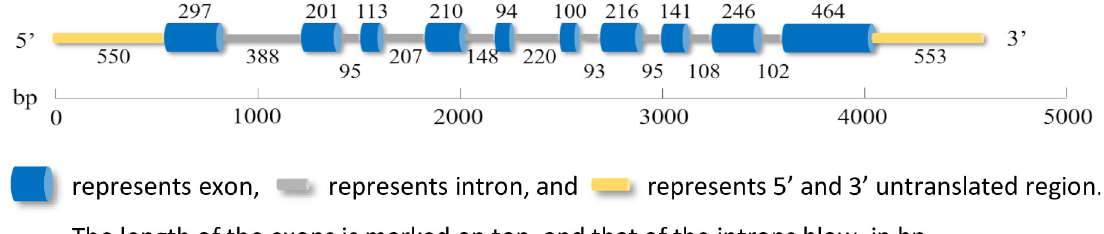
Fig 3. Schematic representation of the PeTPS-(-)Apin gene